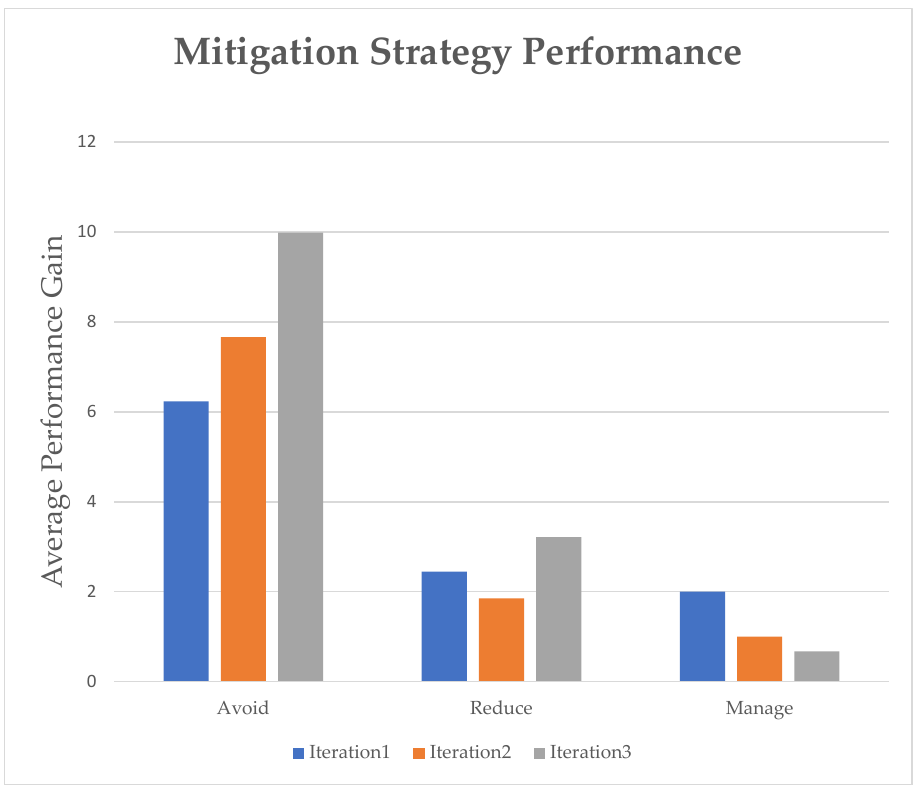
Figure 7. The efficiencies of the various strategy types for case study 1.